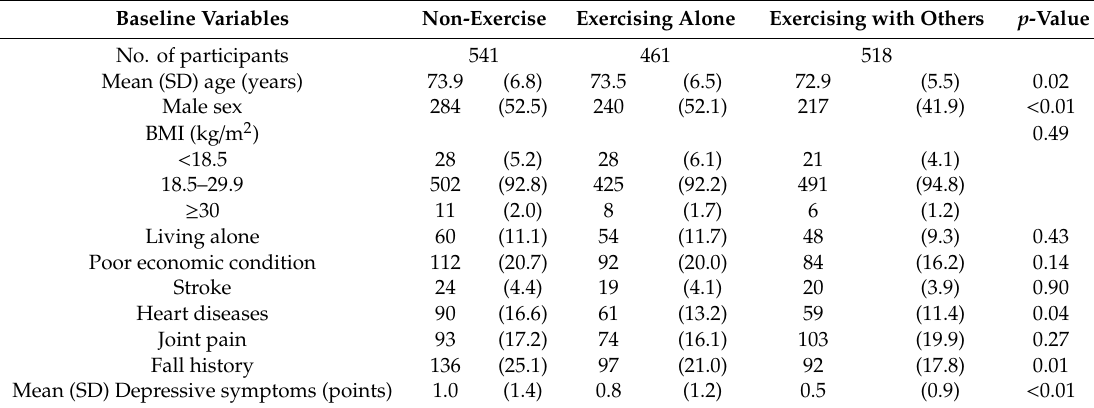
Table 1. Baseline characteristics of participants according to exercise habits. Baseline